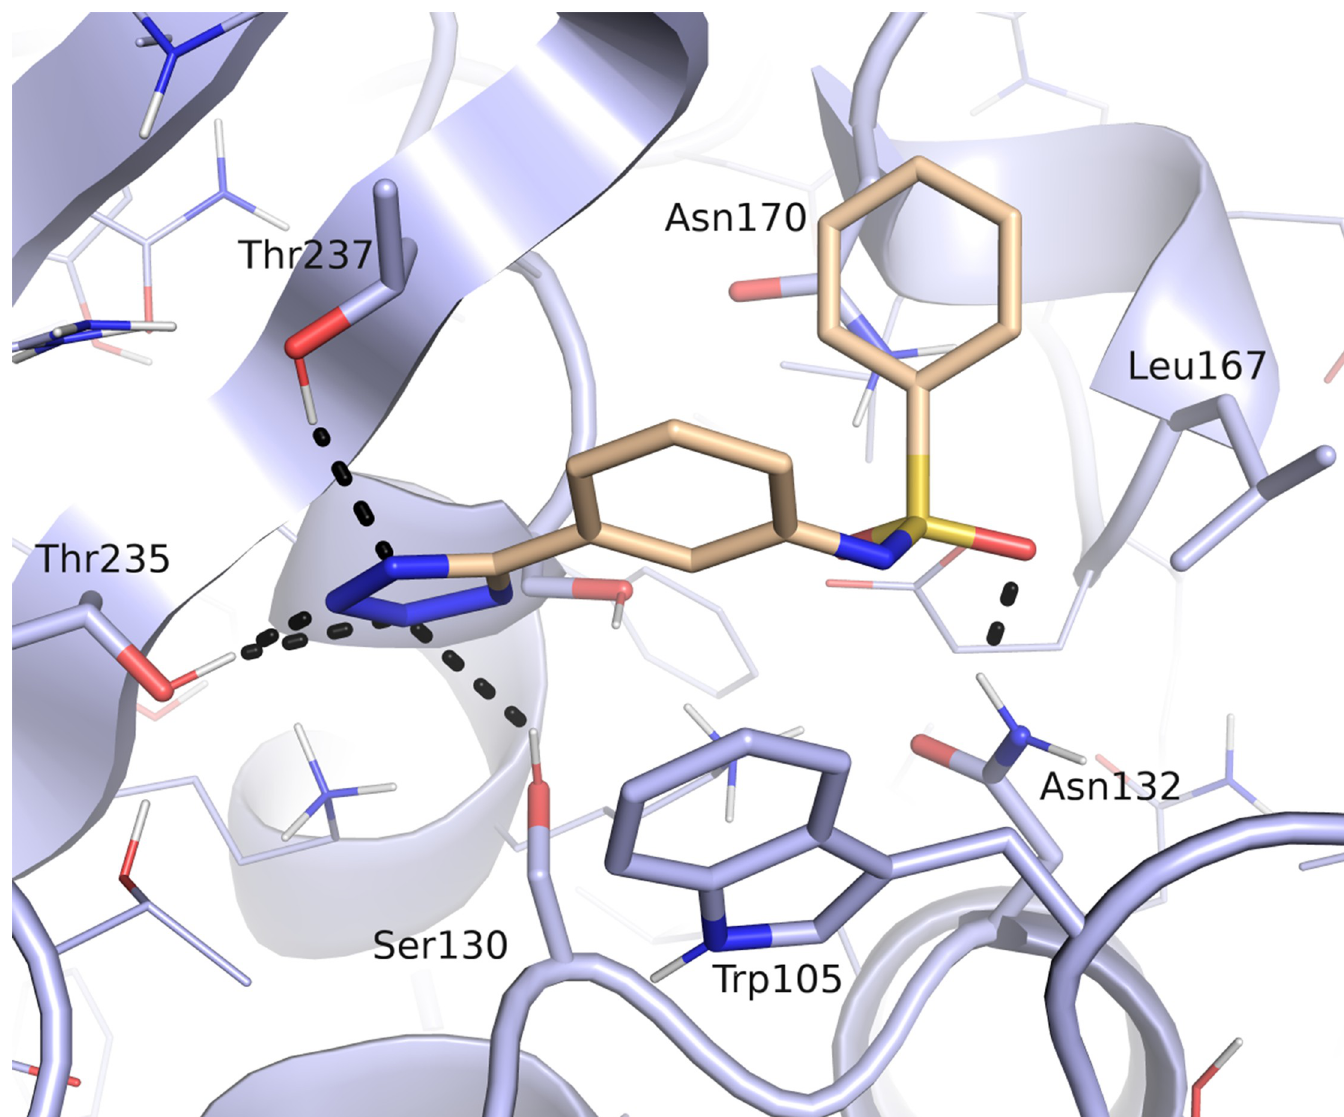
Fig 12. Predicted binding mode of a sulfonamide derivative of compound 11a (beige) in the Kp KPC-2 receptor (blue). Putative hydrogen bond interactions are indicated as black dots (Ambler numbering)[21].